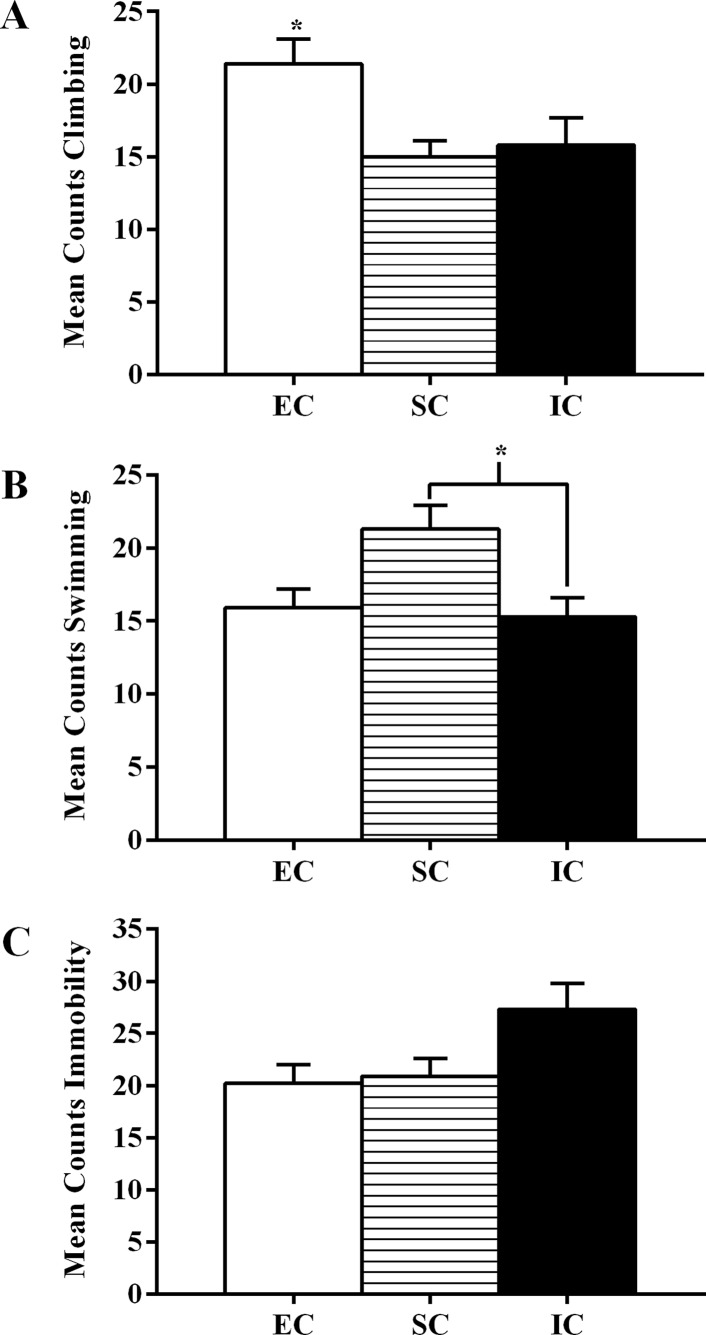
Experiment II Pretest Swimming, Climbing, and Immobility.Experiment II total mean counts (±SEM) of (A) climbing, (B) swimming, and (C) immobility behavior between EC, SC, and IC rats during the first five minutes of the forced swim pretest. (A) Asterisk (*) indicates EC rats exhibited significantly more climbing than both SC and IC rats during the first five minutes of the pretest. (B) Asterisk (*) indicates IC rats exhibited significantly less swimming than SC rats during the first five minutes of the pretest (p < .05).